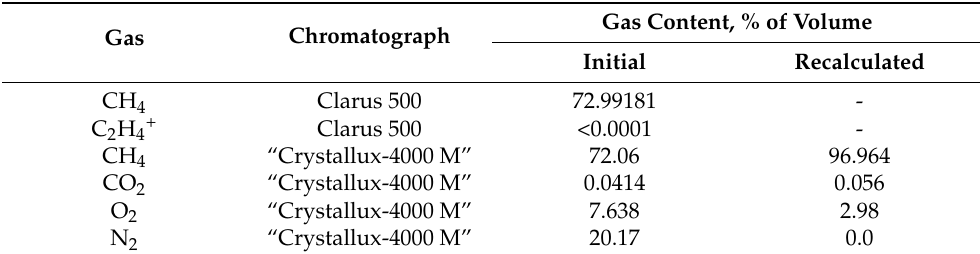
Table 2. Gas composition in samples from the Seykha C11 crater, according to different chromato- graphic